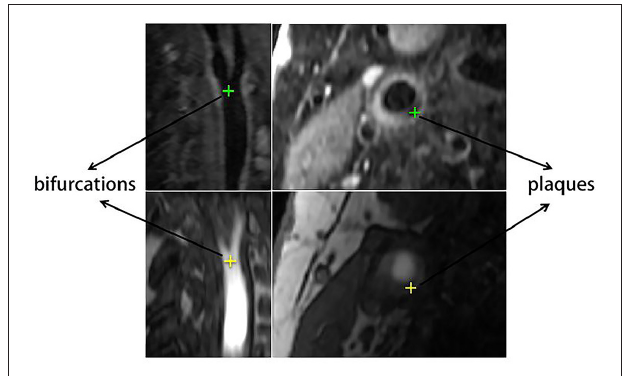
FIGURE 3 | Example of labeled carotid bifurcations and